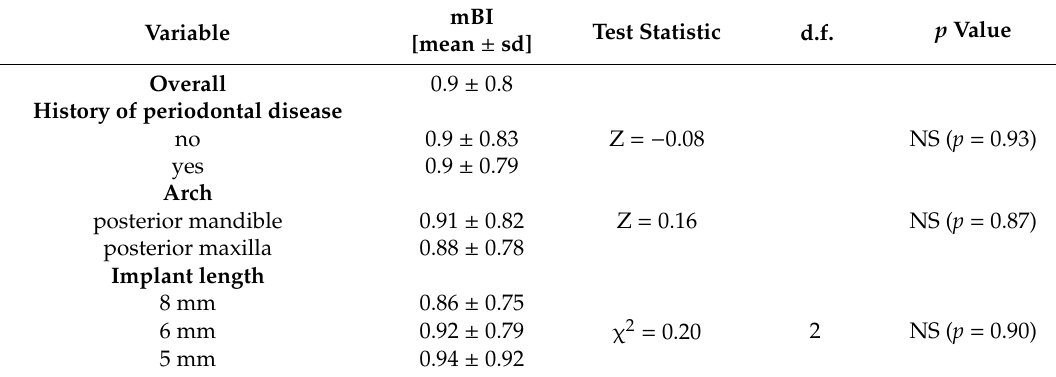
Table 5. Overall soft tissues indices (Modified Bleeding Index (mBI), Modified Plaque Index (mPLI), peri-implant probing depths (PPD) [mm], keratinized tissue (KT) [mm]) according to PP / NPP-groups, length-groups and arch-groups. mBI, mPLI, PPD and KT are presented as mean ± standard deviation; for all other variables, values are presented as n (%); NS = not statistically significant; d.f. = degrees of